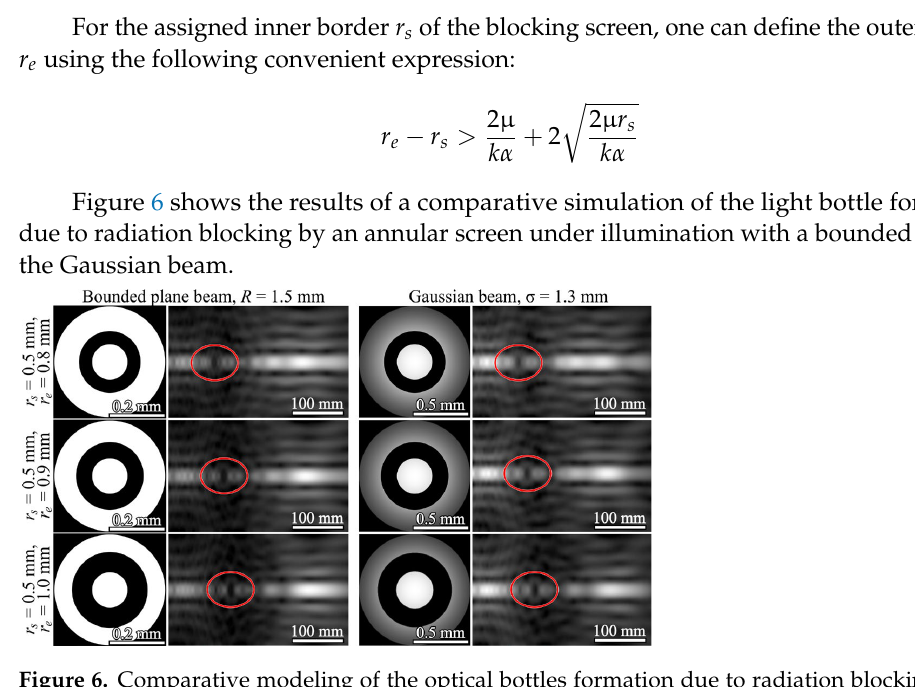
Figure 6. Comparative modeling of the optical bottles formation due to radiation blocking by an annular screen under illumination with a bounded flat and the Gaussian beam (the amplitude dis- tribution along the optical axis is shown x ∈ [ − 0.2 mm; 0.2 mm], z ∈ [50 mm; 400 mm]).